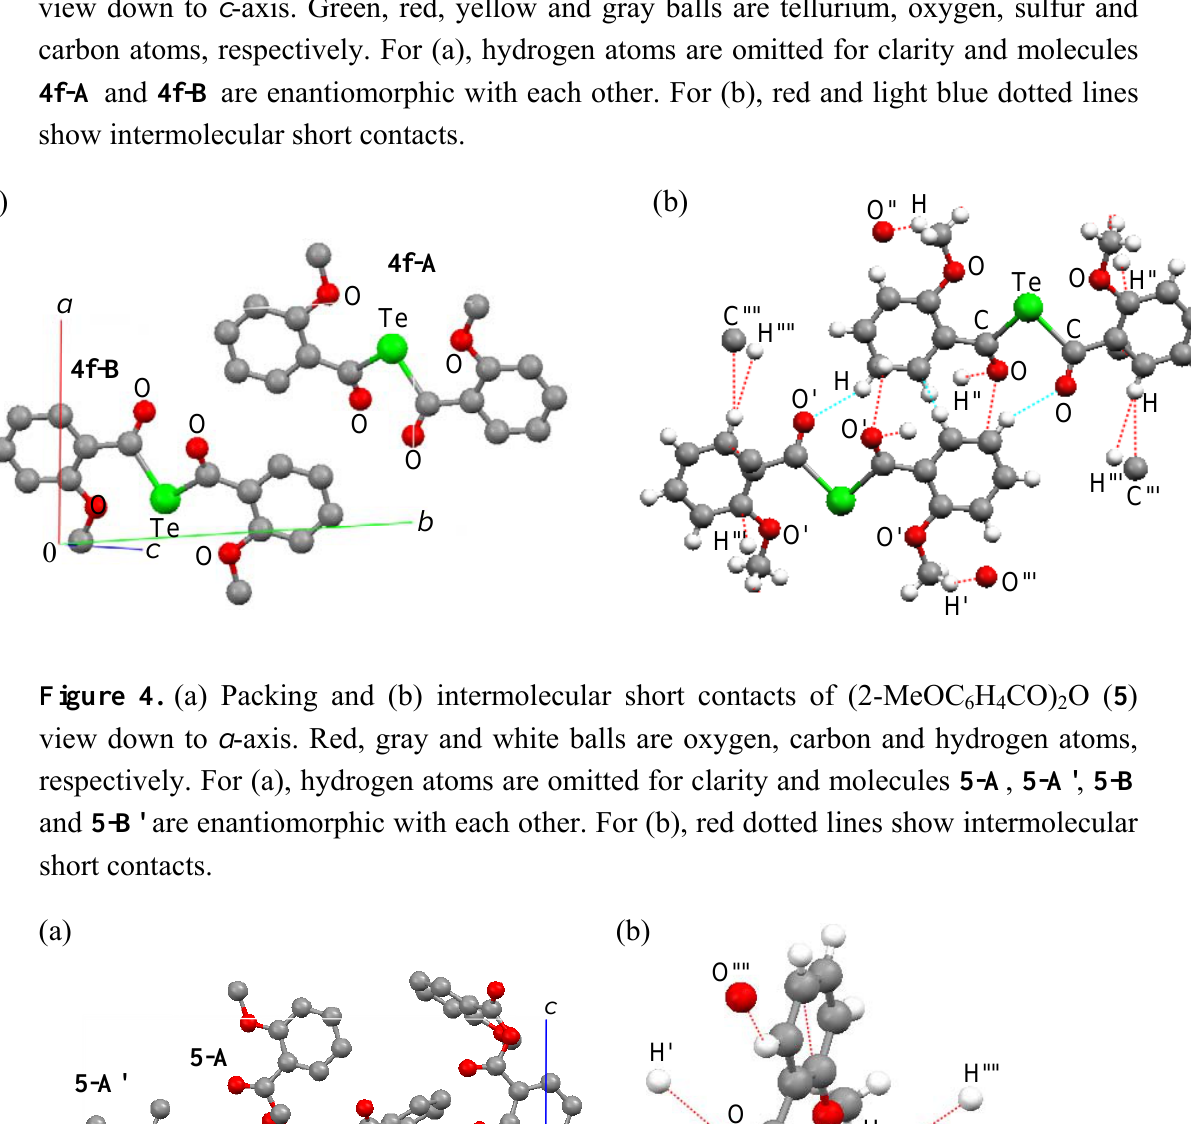
H CO) Te ( 4f ), 6 4 2